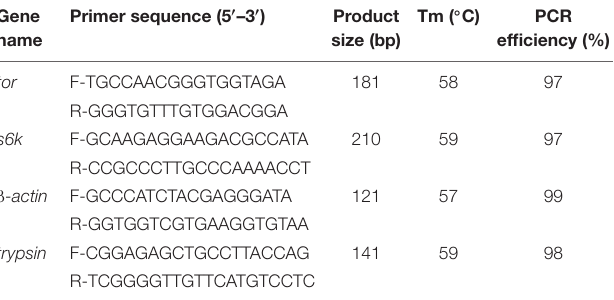
TABLE 4 | Primers used for real-time quantitative